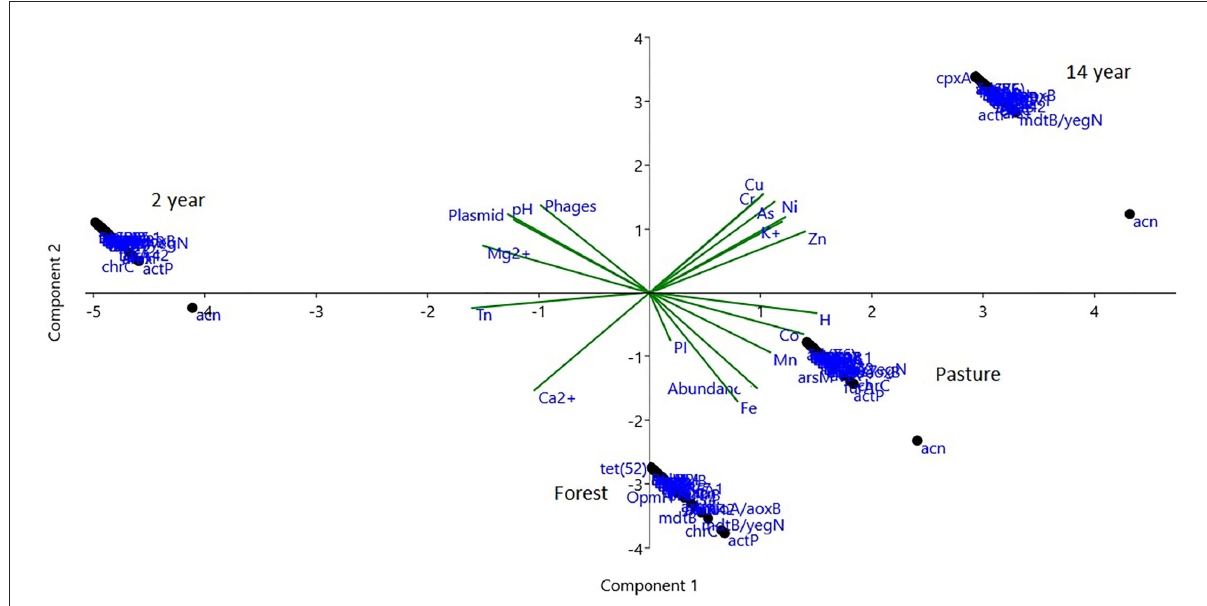
FIGURE8 PCA analysis of genes with a greater abundance of antibiotic and biocide resistance genes, Shannon’s alpha diversity index (H) also of plasmid mobile elements, phages, and transposons (Tn), pathogenicity islands (PI) with the chemical characteristics of pH, cations, and heavy